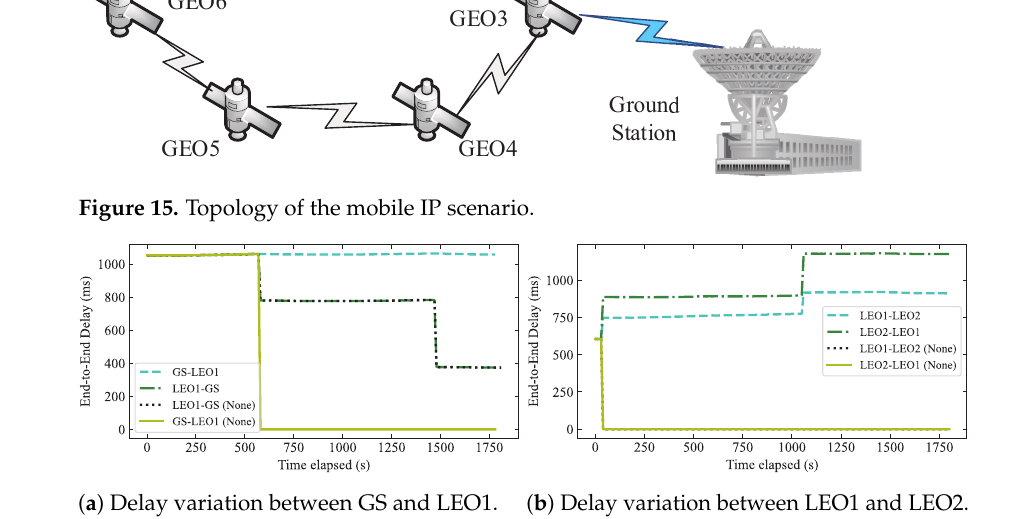
Figure 16. Delay